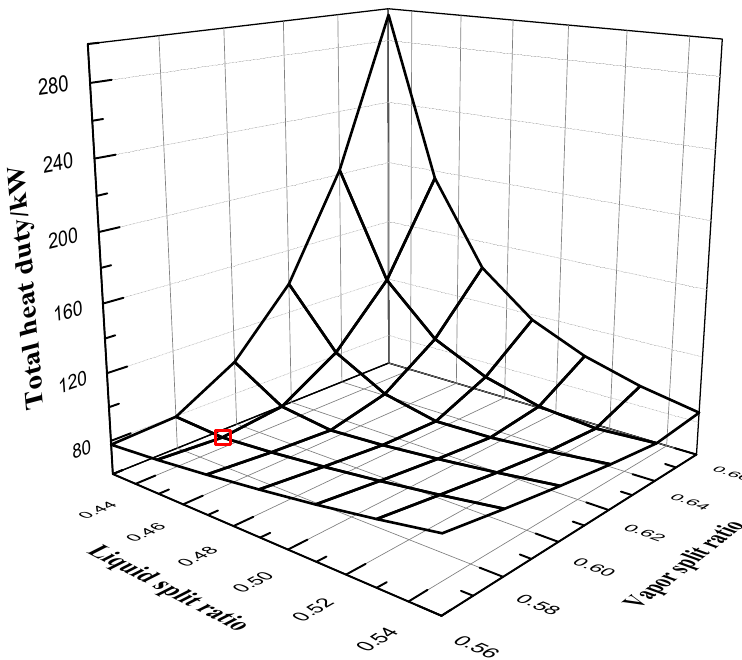
Figure 14. The total heat duty versus liquid and vapor split ratios for the case study.